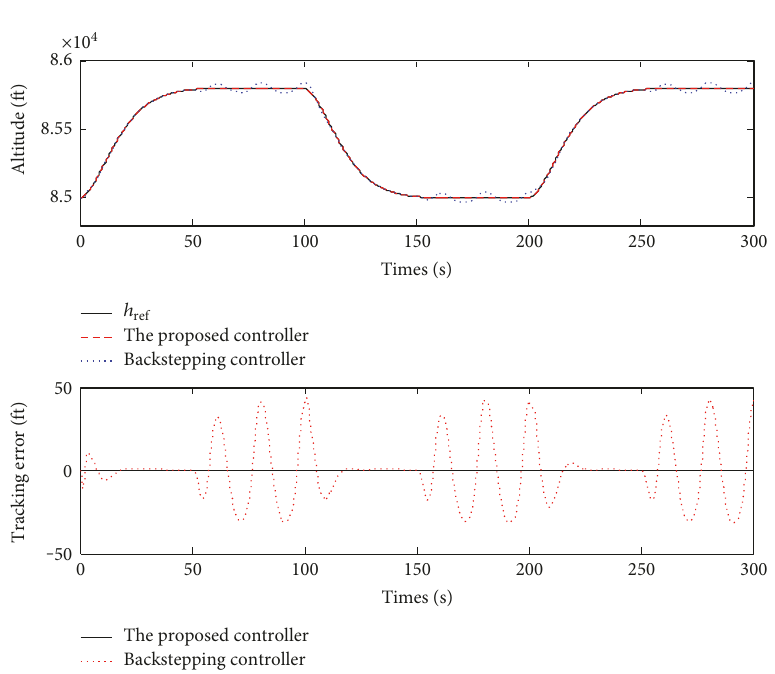
Figure 9: Altitude tracking and tracking